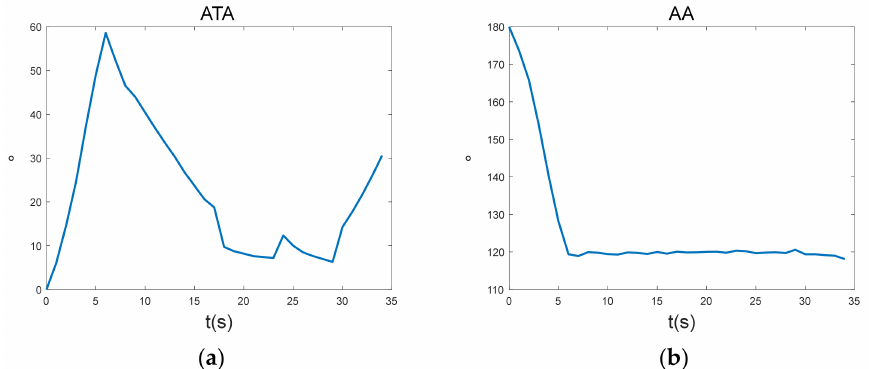
Figure 12. ATA and AA change curves. ( a ) UCAV; ( b )